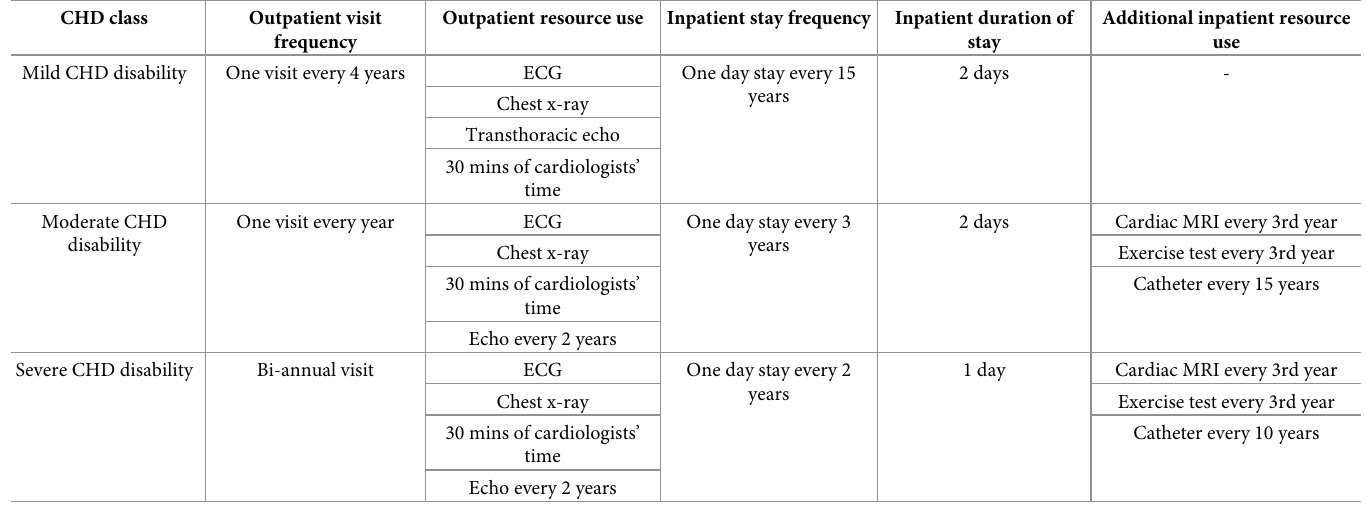
Table 8. Resource use data by CHD